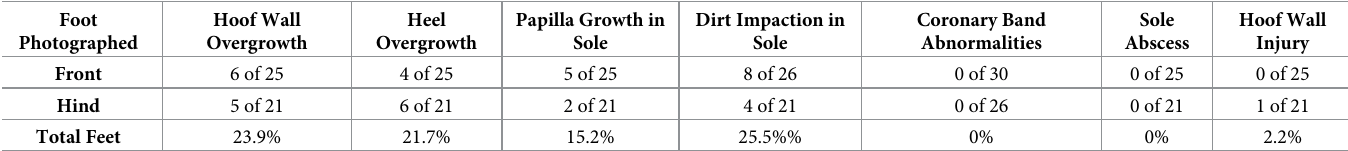
Table 4. Photographs demonstrate that hoof and heel overgrowth and dirt impaction of the sole was regularly present but foot pathologies were uncommon in free-ranging giraffe. Foot Photographed